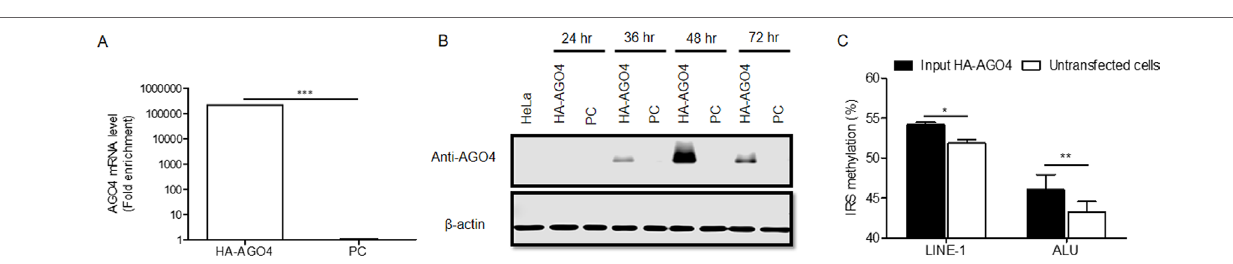
FIGURE 5 | Overexpression of HA-AGO4 increases global genomic methylation. (A) Confirmation of AGO4 mRNA expression in AGO4- or PC-overexpressing cells after transfection for 72 h by using real-time PCR showed that AGO4 mRNA was significantly upregulated in AGO4-overexpressing cells, and (B) Western blot analysis showed the expression of the HA-AGO4 protein in a time-course experiment. β -Actin was used to confirm equal protein loading of each lane. AGO4 protein expression was at the highest level at 48 h after transfection. (C) Overexpression of HA-AGO4 resulted in a significant increase in interspersed repetitive sequence methylation in the input (cell lysate) HA-AGO4 compared with untransfected HeLa cells, detected at 72 h post-transfection. The above data in A and C are the representative dataset from five independent experiments presented as the mean ± SEM. Statistical analyses were performed using a paired t -test where p < 0.05, p < 0.01, and p < 0.005 are represented as *, **, and ***, respectively.